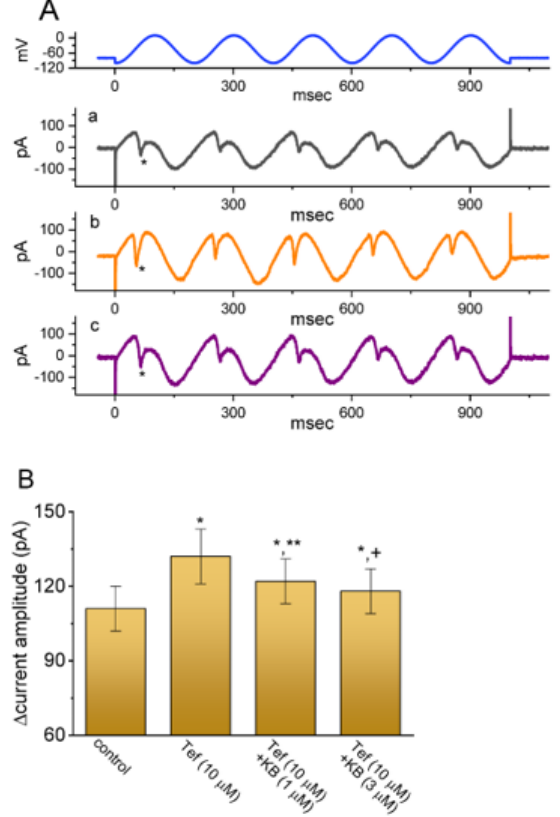
Figure 7. Attenuating effect of KB − R7943 on tefluthrin-stimulated I Na(P) activated in response to sinusoidal voltage waveform. The tested cell was held at − 80 mV, and the voltage clamp protocol designed to consist of sinusoidal voltages between − 100 and 0 mV with a rate of 5 Hz for a duration of 1 sec was afterwards applied to it. ( A ) Exemplar current traces obtained in the control period (a, black color, i.e., neither Tef nor KB (KB − 7943) was present), and during cell exposure to either 10 µ M Tef (b, orange color) or 10 µ M Tef plus 3 µ M KB − R7943 (c, purple color). The asterisk in each panel indicates a transient inward deflection corresponding with the occurrence of I Na(P) activated in response to sinusoidal voltage waveform. ( B ) Effect of tefluthrin (Tef) and Tef plus KB − R7943 (KB, 1 or 3 µ M) on ∆ current amplitude of I Na(P) activated in response to sinusoidal voltage command (mean ± SEM; n = 7 for each brown bar). The absolute value of ∆ current amplitude of I Na(P) shown on the y-axis was measured when the difference between current amplitude at − 60 mV and that at − 30 mV was taken. * Significantly different from control ( p < 0.05), ** significantly different from Tef (10 µ M) alone group ( p < 0.05), + significantly different from Tef (10 µ M) plus KB (1 µ M) group ( p <